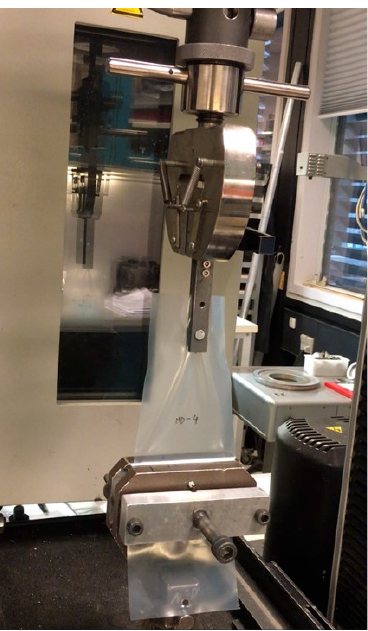
Figure 2. Sample mounted in the tensile testing machine.